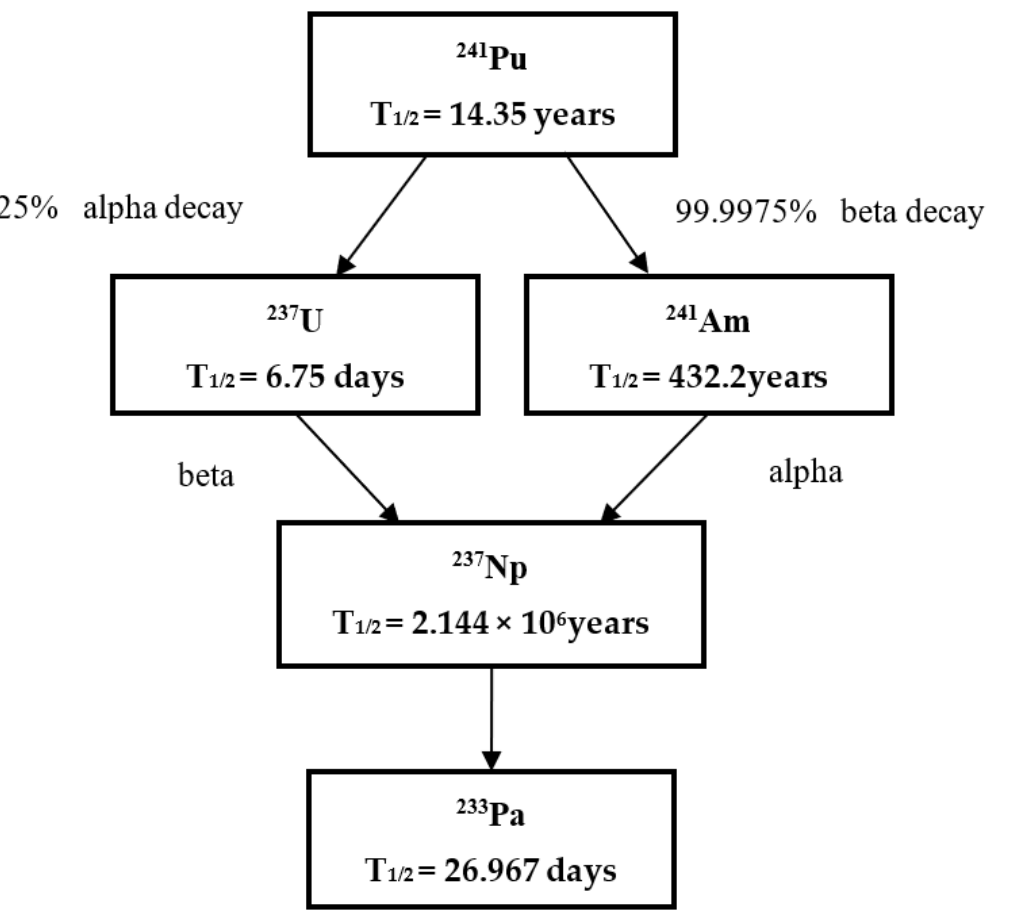
Figure 2. The decay chain of 241 Pu.